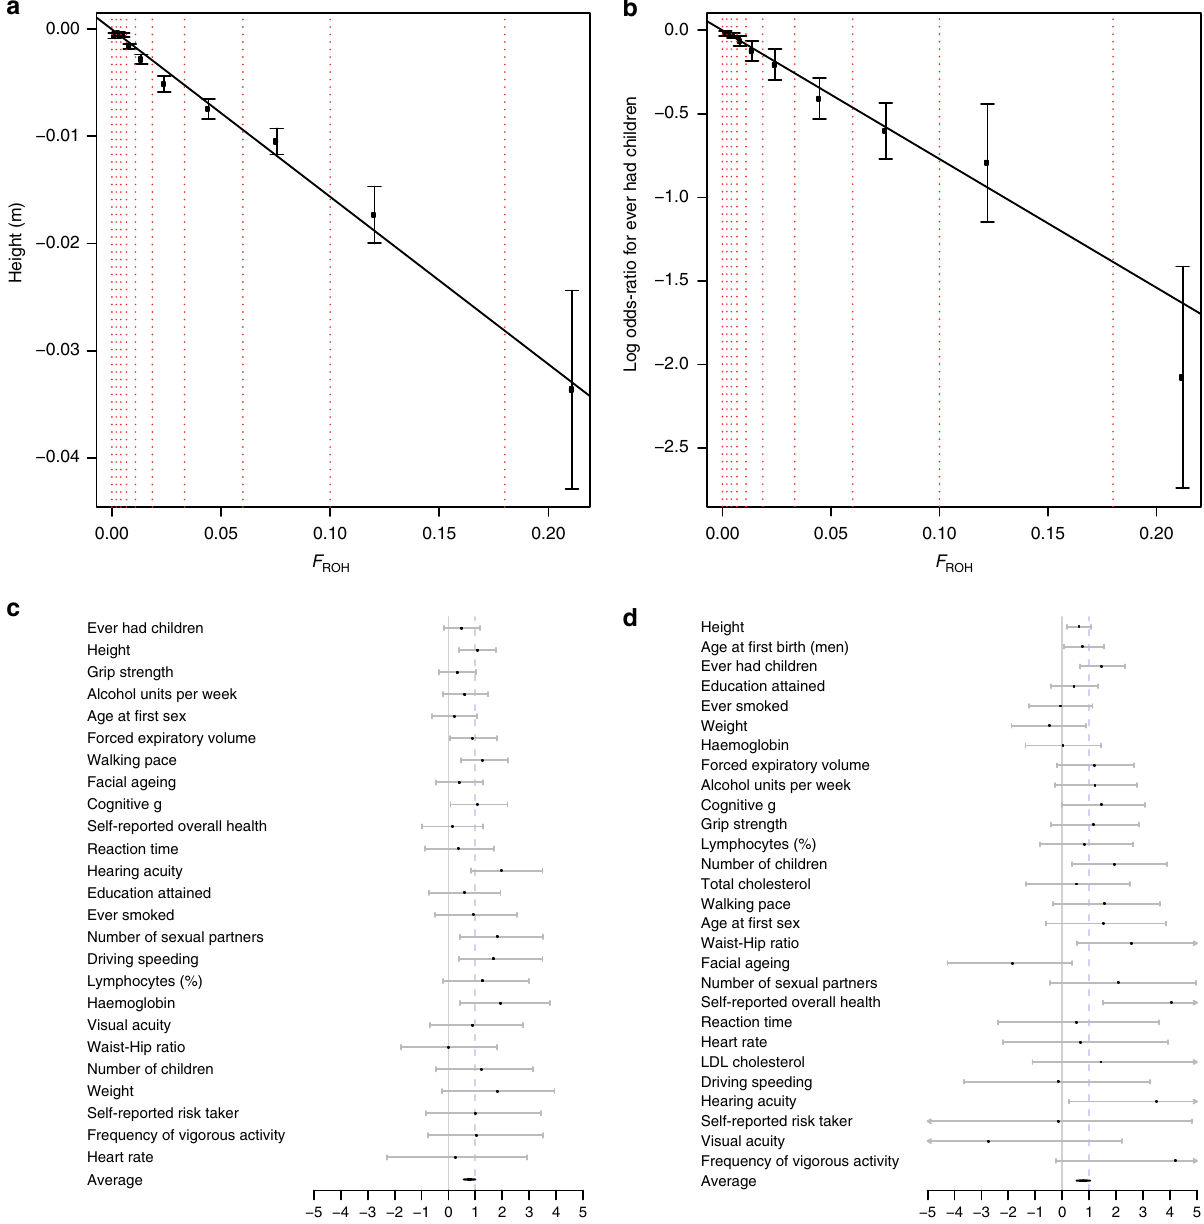
: β ) are presented by trait. Twenty-three F ROH wSibs ROH